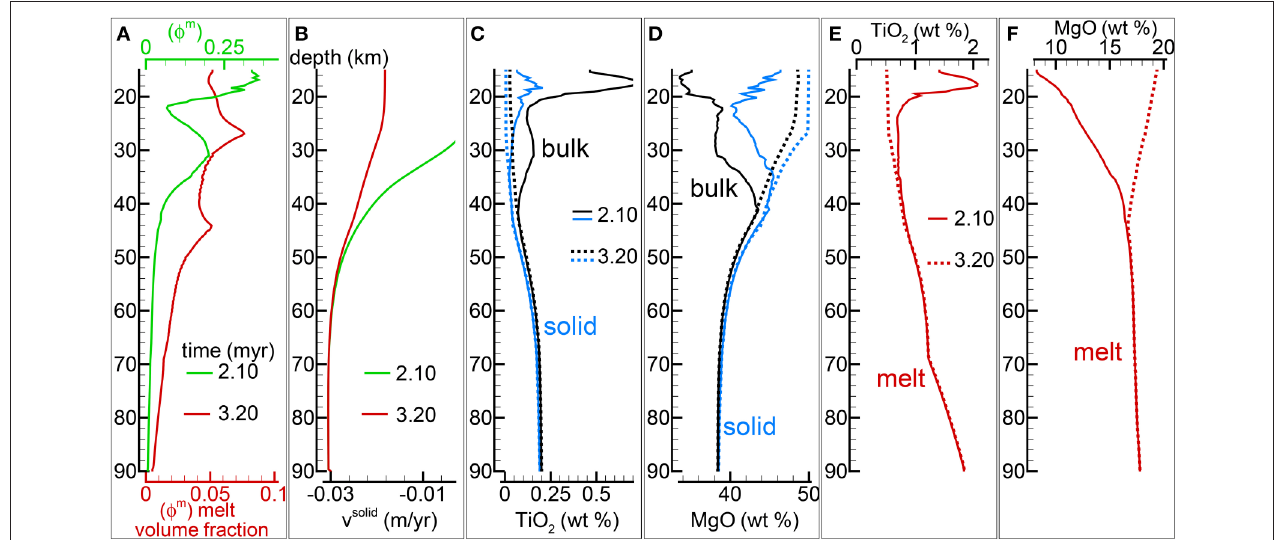
FIGURE 5 | Two-phase flow dynamic melting with thermodynamic computation applied every 8 time steps, solid viscosity model: µ s = µ s 0 (1 + 1 /φ m ) with µ s 0 = 1 e 20 Pa s. Additional details related to this simulation are discussed in section “Results from the Dynamic Equilibrium Melting Model.” (A) Melt volume fraction vs. depth at 2 different times. Earliest time indicates approximately the first arrival of melt at the top. (B) Velocity of the solid matrix. (C) Variation of TiO 2 in solid and bulk (melt + solid) (wt %). (D) Variation of MgO in solid and bulk (melt + solid) (wt %). (E) Variation of TiO 2 in melt (wt %). (F) Variation of MgO in melt (wt %). The complete data for all 12 oxides in melt solid and bulk, at every depth over time are included in the data file PHASE3-P2.YRC13.DAT (zip file max-front1-data2.zip ). A movie of this simulation is available (movie file mf1-movie4.PHASE3-P2.YRC13.avi ). The instructions to retrieve both files are provided in the Supplementary